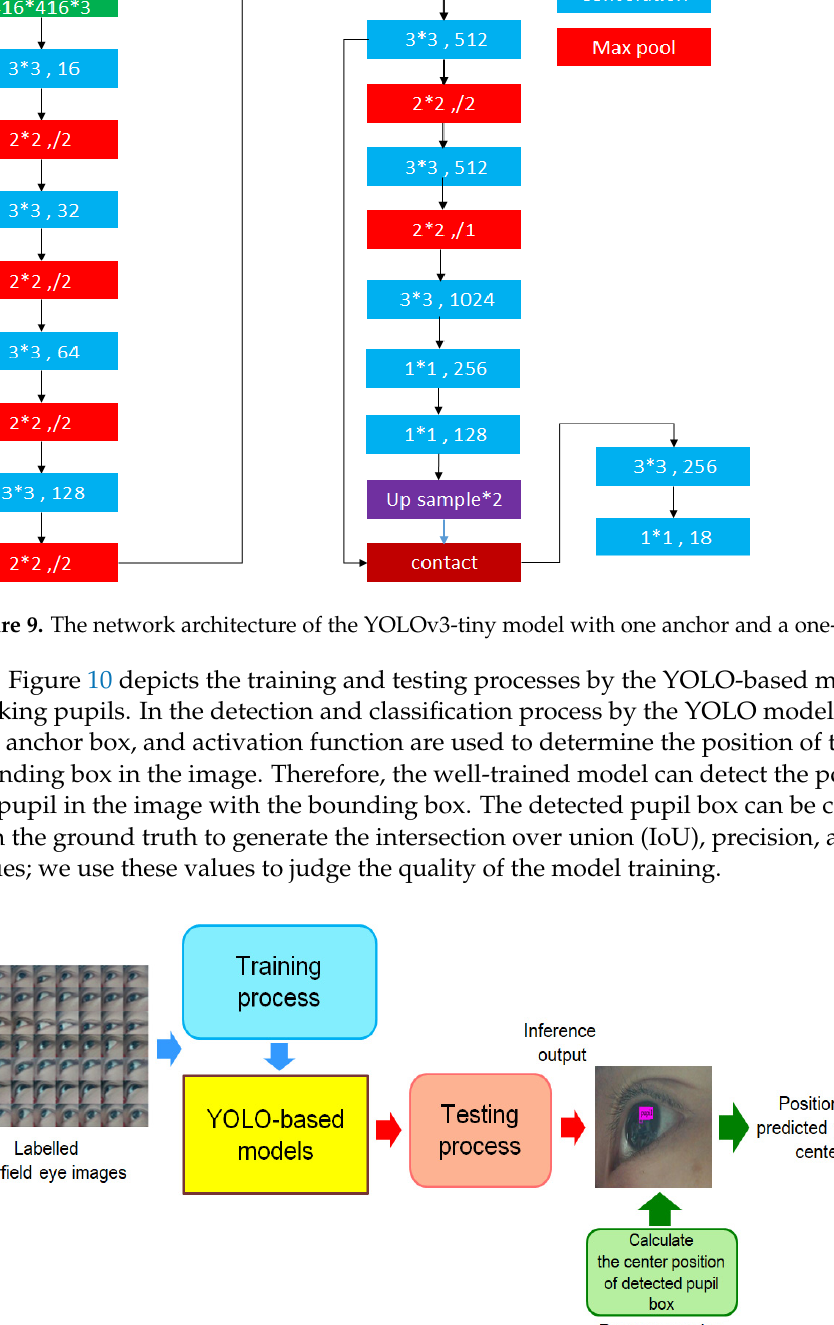
Table 2. Confusion matrix for classification.